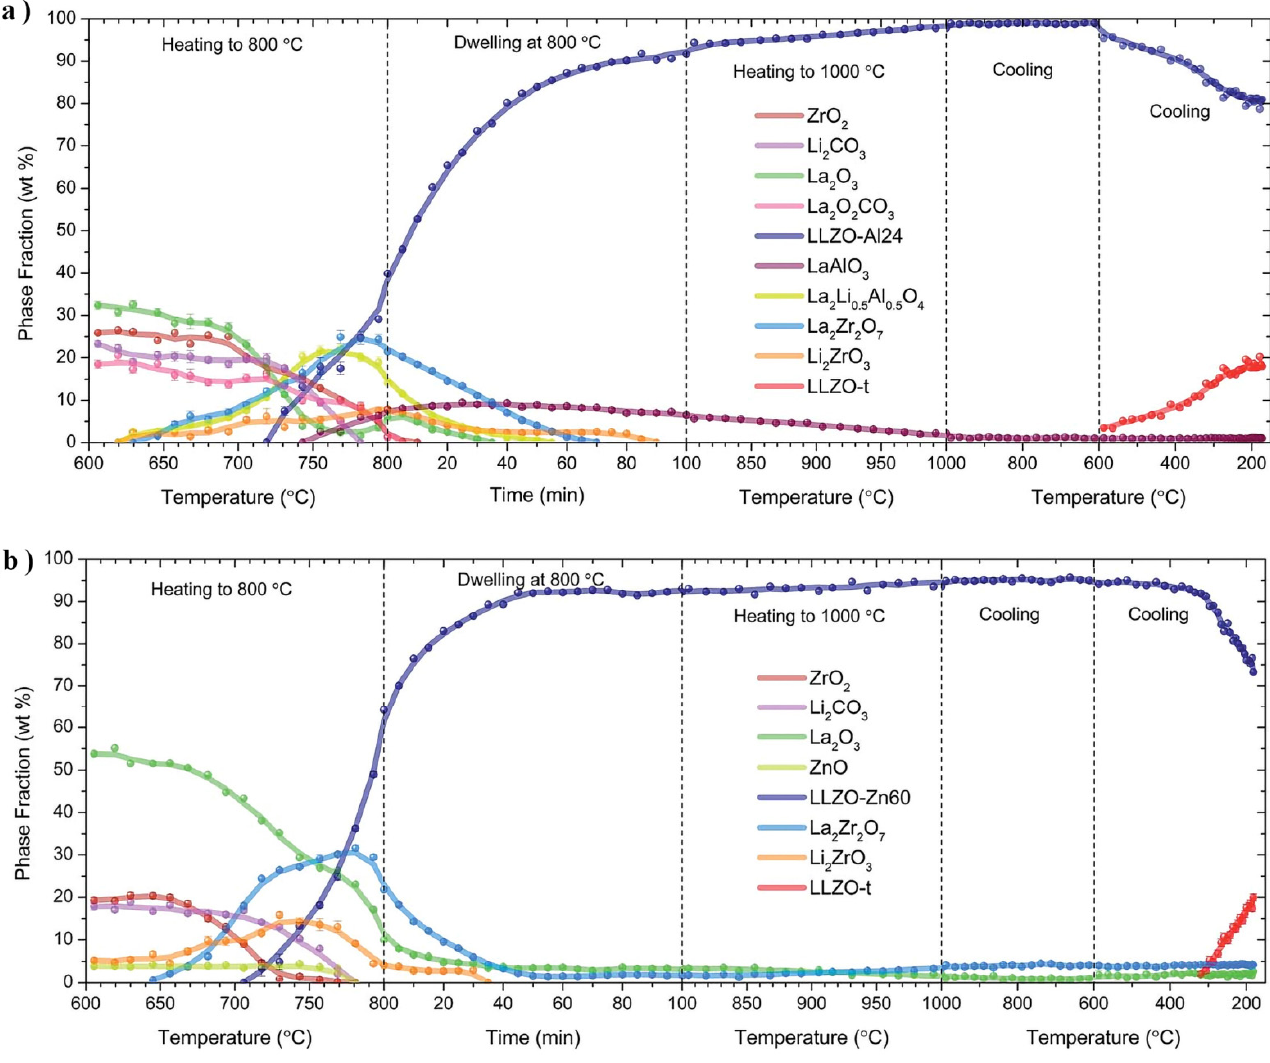
Figure 3. In situ NPD synthesis of ( a ) LLZO-Al 24 and ( b ) LLZO-Zn 60 with intermediate phases La 2 Zr 2 O 7 and Li 2 ZrO 3 (adapted with permission Ref. [34]. 2015 The Royal Society of Chemistry).